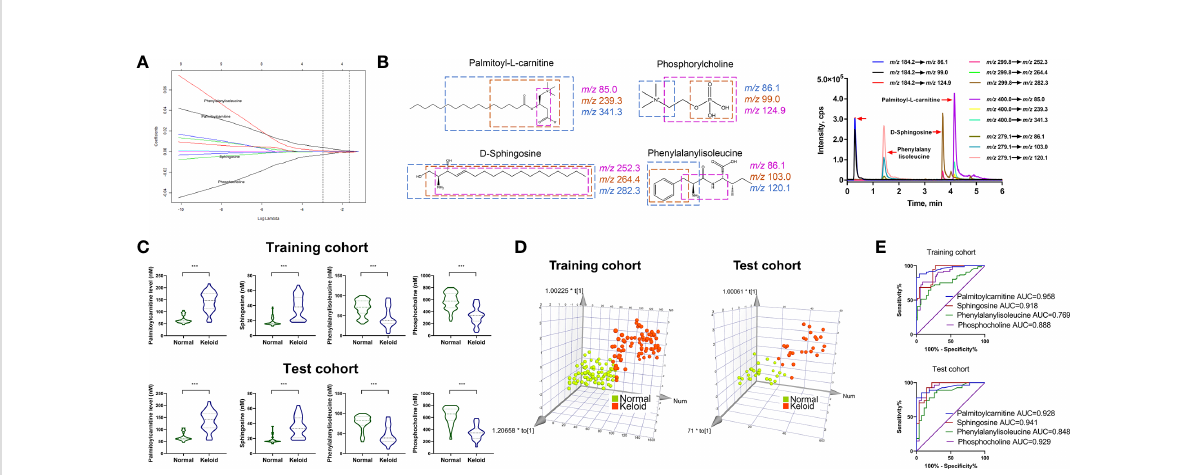
FIGURE 4 Development of MRM-based target metabolite quanti fi cation method and detection of the abundance offour target metabolites. (A) LASSO coef fi cient pro fi les of the nine features. (B) Chemical structure, fragmentation, and representative MRM chromatograms of palmitoylcarnitine, sphingosine, phosphocholine, and phenylalanylisoleucine. (C, D) Respective expression of palmitoylcarnitine, sphingosine, phosphocholine, and phenylalanylisoleucine and the 3D PCA score plot based on the 4-metabolite fi ngerprint classi fi er in the training and test cohorts. (E) ROC analysis of palmitoylcarnitine, sphingosine, phosphocholine, and phenylalanylisoleucine in predicting keloid in the training and test cohorts. *p < 0.05 and ***p < 0.001.